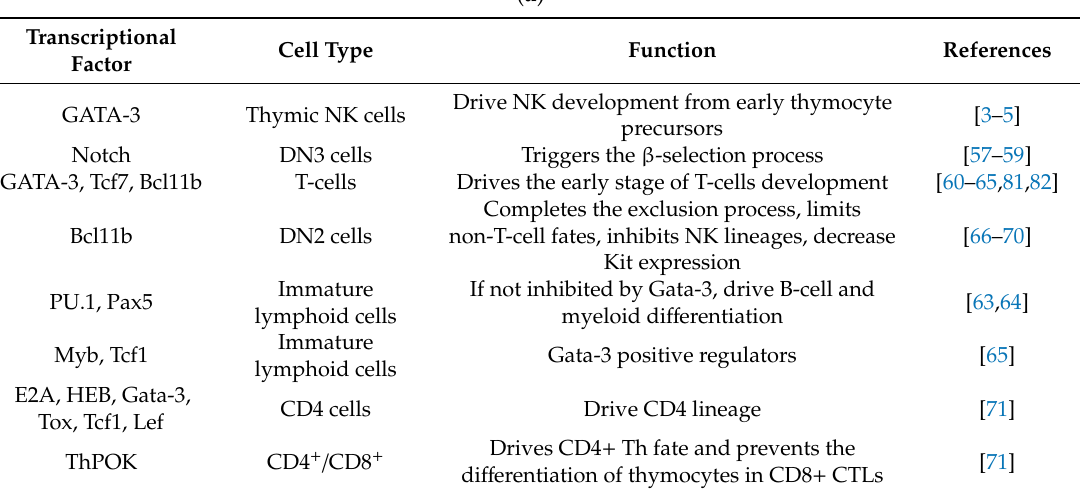
Table 4. ( a ) Major transcriptional factors involved in thymocyte development; ( b ) Major transcriptional factors involved in thymic stromal population